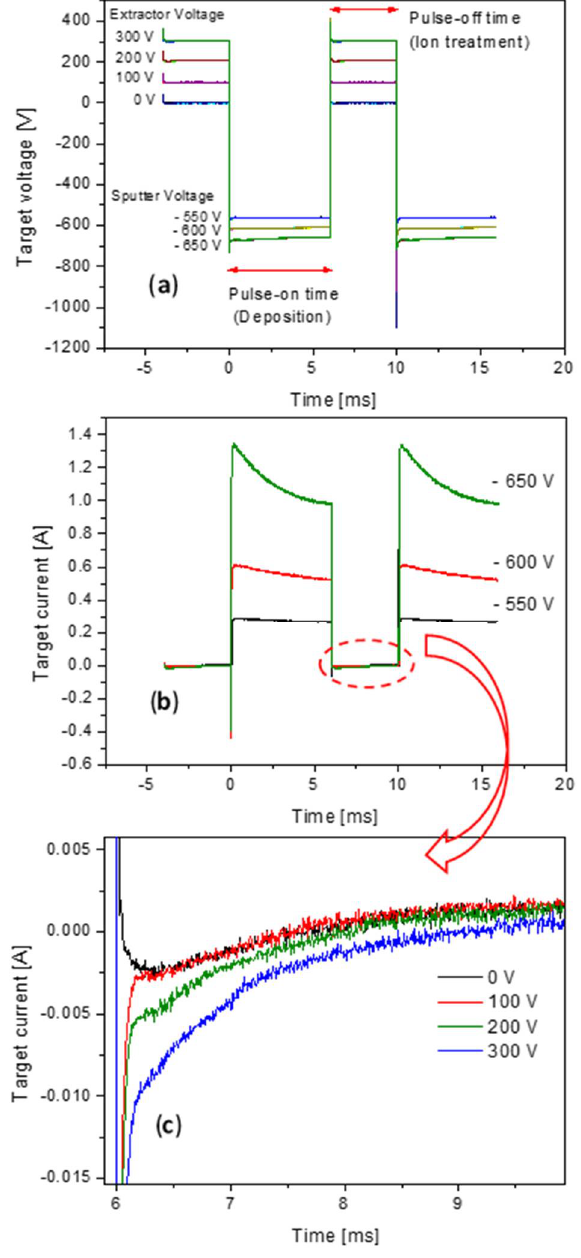
Figure 2. Target voltage and current waveforms at different sputter and extractor voltages as a function of the time. ( a ) Target voltage, ( b ) target current, and ( c ) high−resolution oscilloscope traces of the target current during the pulse−off time.